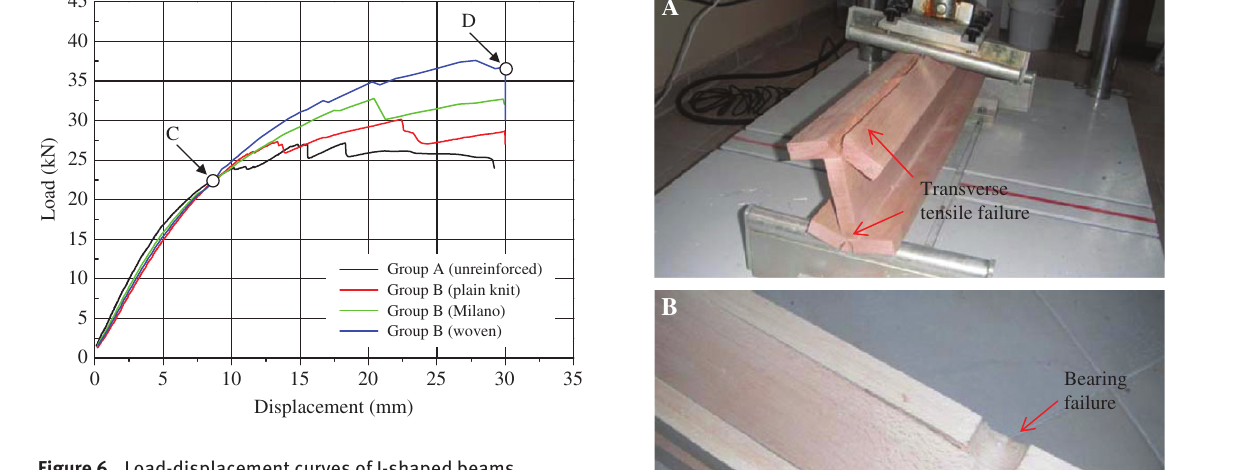
Figure 6 Load-displacement curves of I-shaped